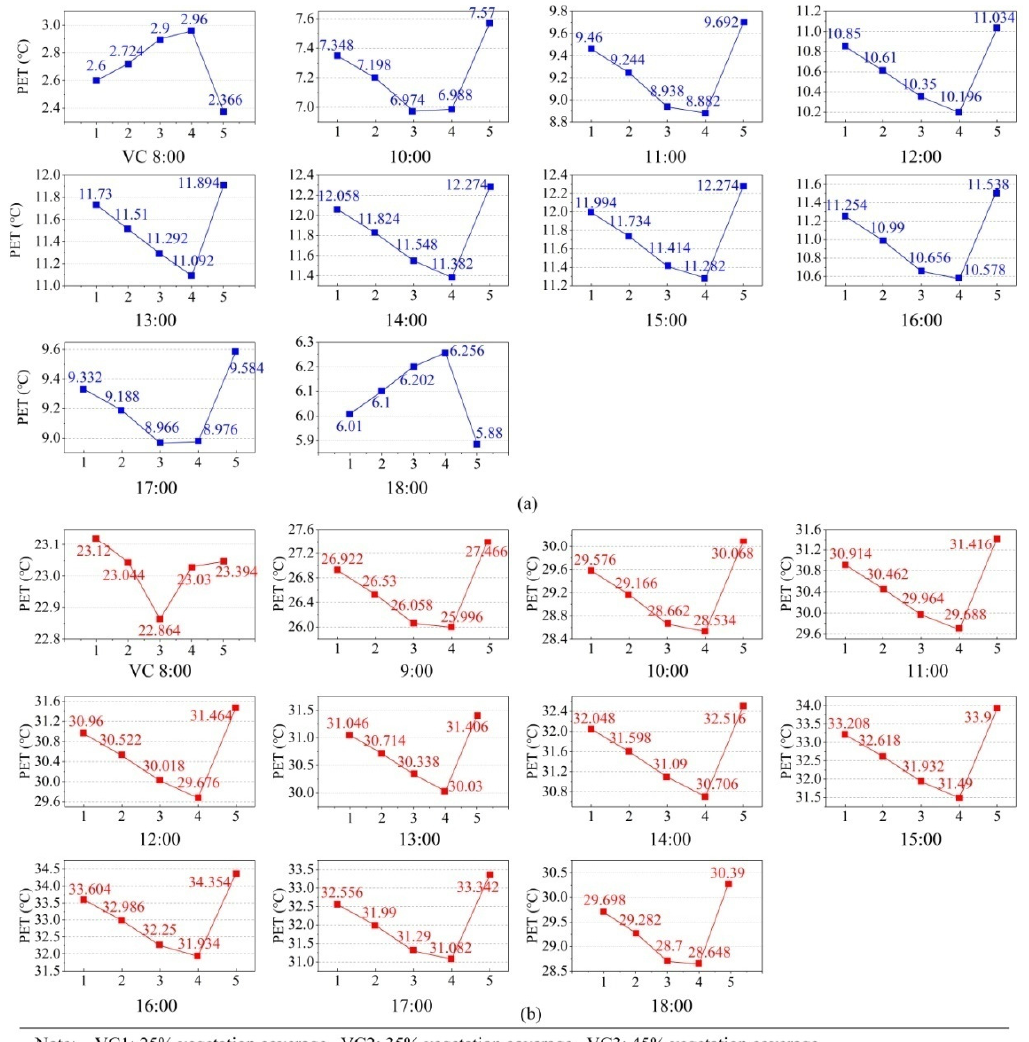
Figure 14. Effect diagrams of VC (vegetation coverage) in winter and summer: ( a ) effect diagrams of VC in winter and ( b ) effect diagrams of VC in summer.